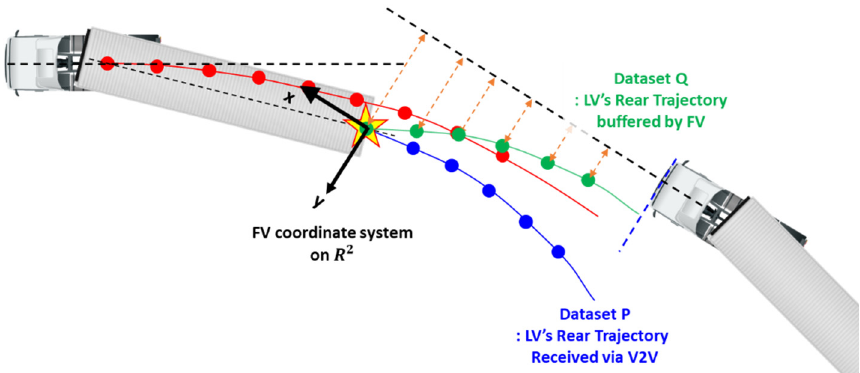
Figure 16. LV trajectory defined in the FV coordinate system.